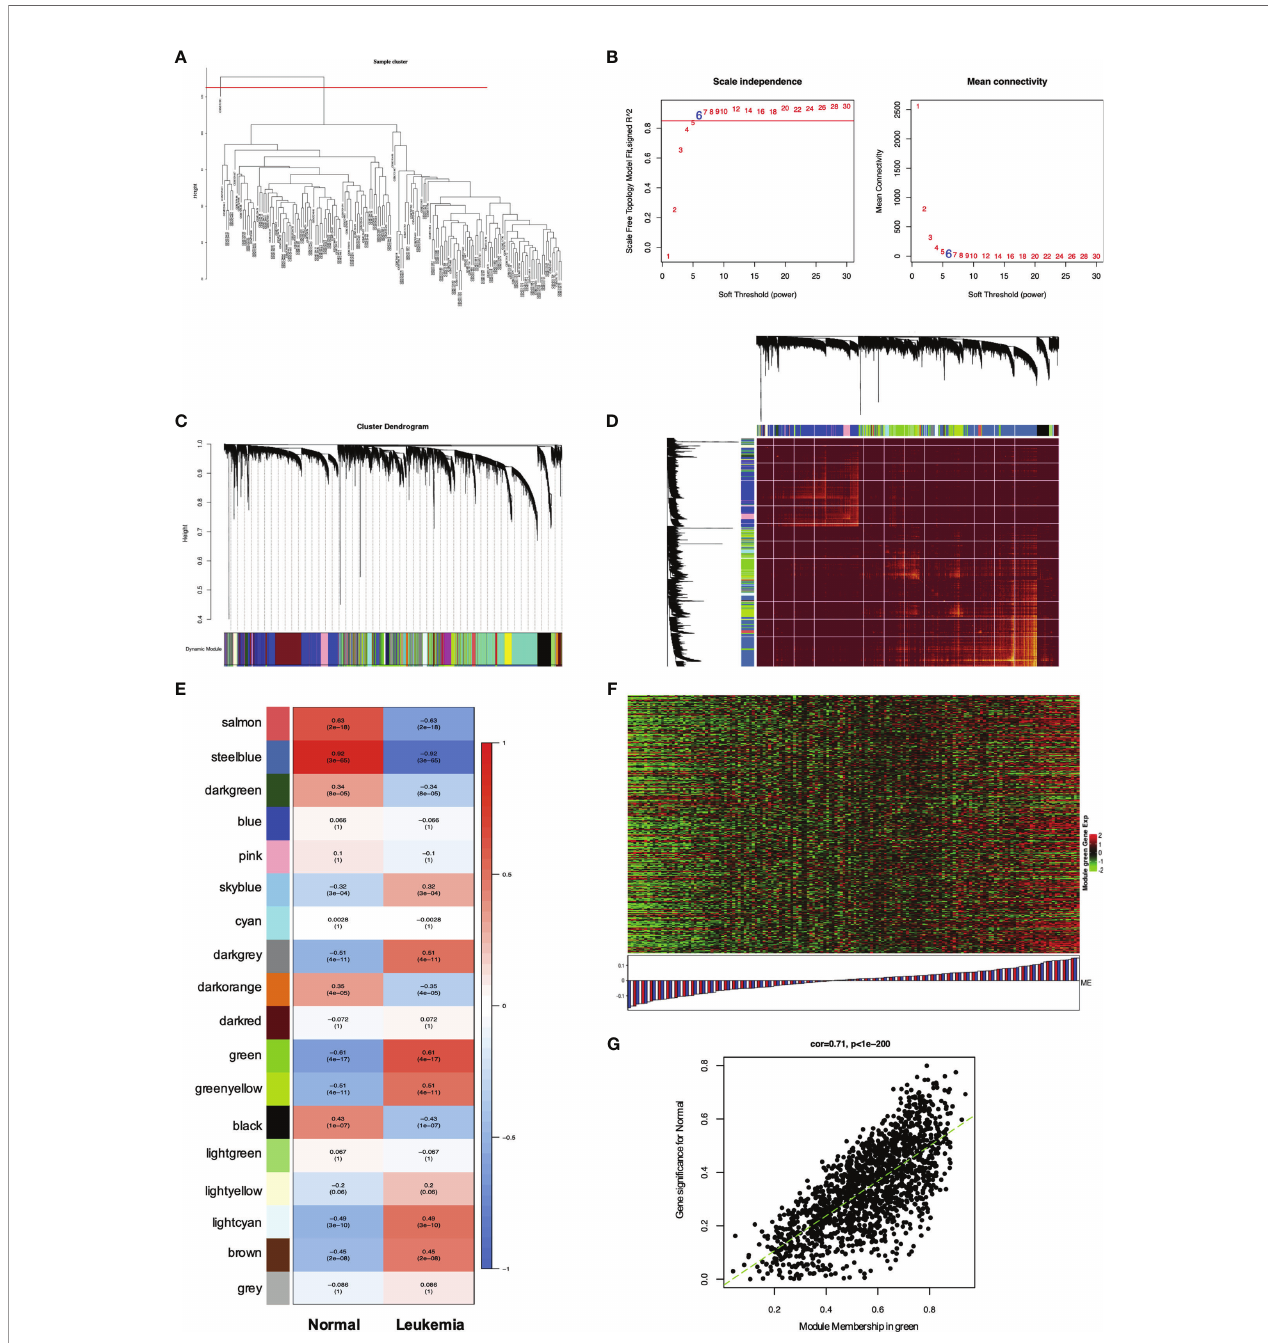
FIGURE 5 | WGCNA of genes and modules in MLL -r ALL. (A) Cluster dendrogram of 165 samples. (B) Analysis of the scale-free fi t index for various soft thresholding powers ( b ) and the mean connectivity for soft threshold power. (C) Hierarchical cluster tree showing adjacency modules based on topological overlap. (D) Heatmap of all DEGs formed a TOM plot to visualize the module structure. In the TOM plot, light yellow color represents low overlap and darker yellow color indicates higher overlap. Left side and the top side of the heatmap show the gene dendrogram and module assignment. (E) Correlation between each module and trait. Each row represents a module eigengene and each column represents a clinic trait. Each cell contains the correlation and p -value of each module. (F) Heatmap for the DEGs in the green module. (G) A scatter plot of eigengenes signi fi cance versus modular membership in the green module. Intramodular analysis of the genes found in the green module showed a high correlation with leukemia, with p < 1e-200 and correlation =